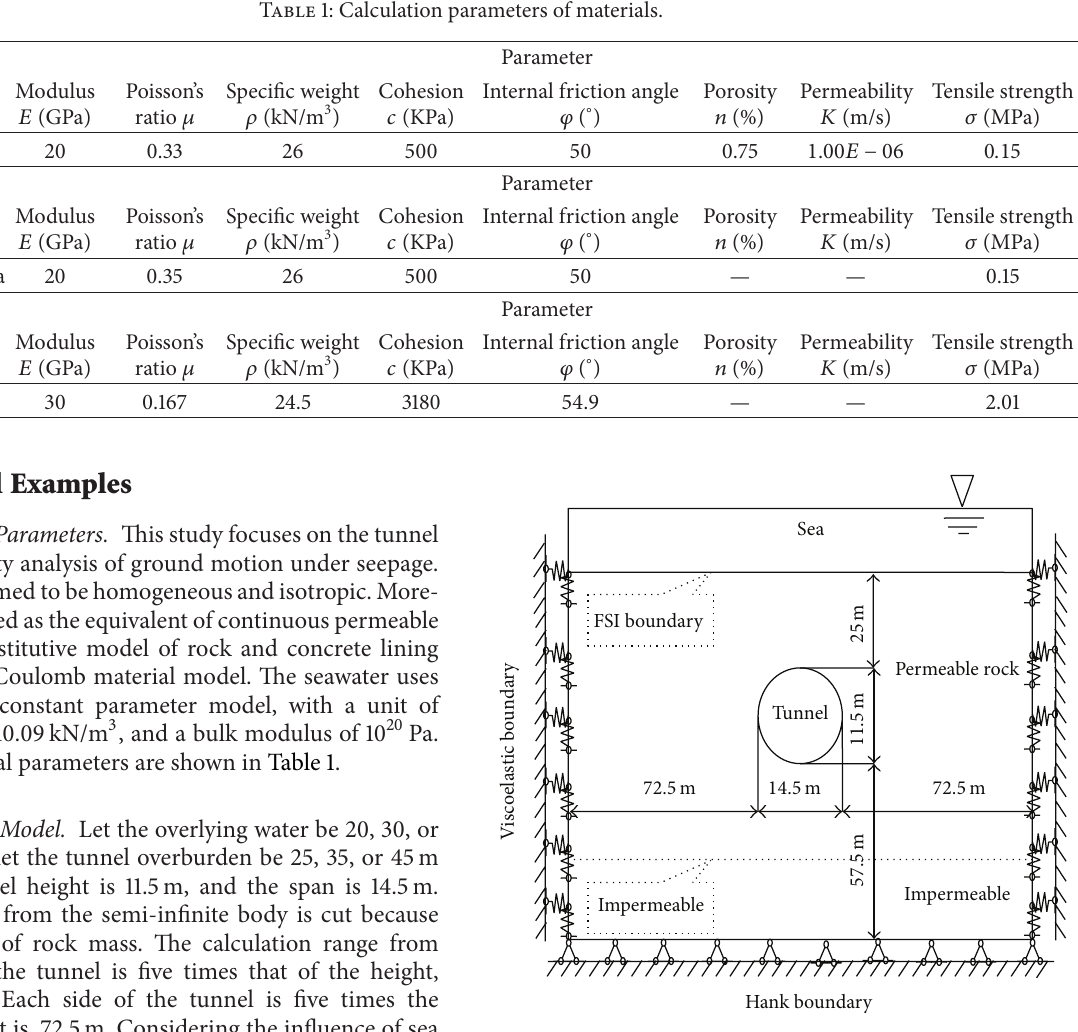
Figure 2: Analysis model.